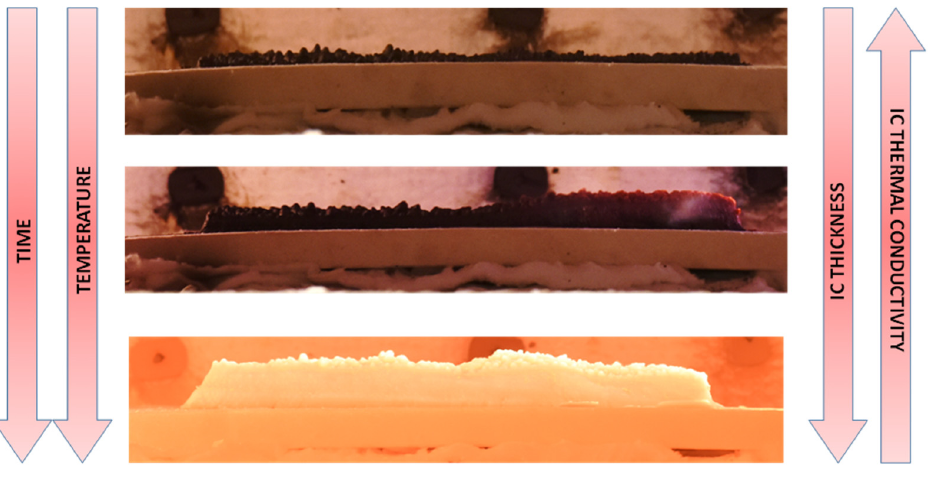
Figure 2. Fire behavior of ICs.